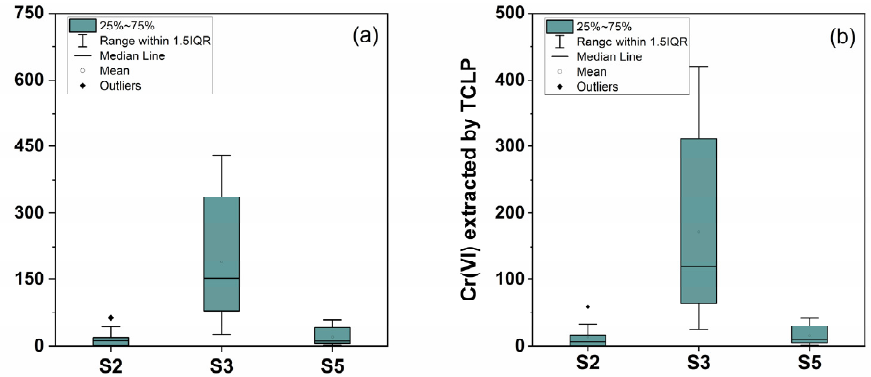
Figure 5. The contents of ( a ) total Cr and ( b ) Cr(VI) extracted by TCLP in contaminated soils at S2, S3 and